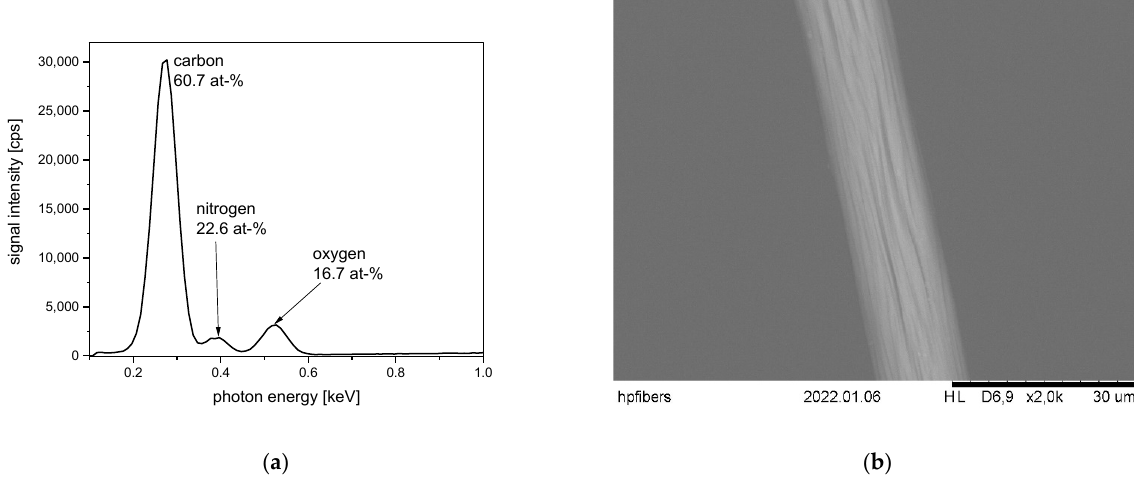
Figure 20. Panox fiber—( a ) EDS spectrum; ( b ) SEM image.